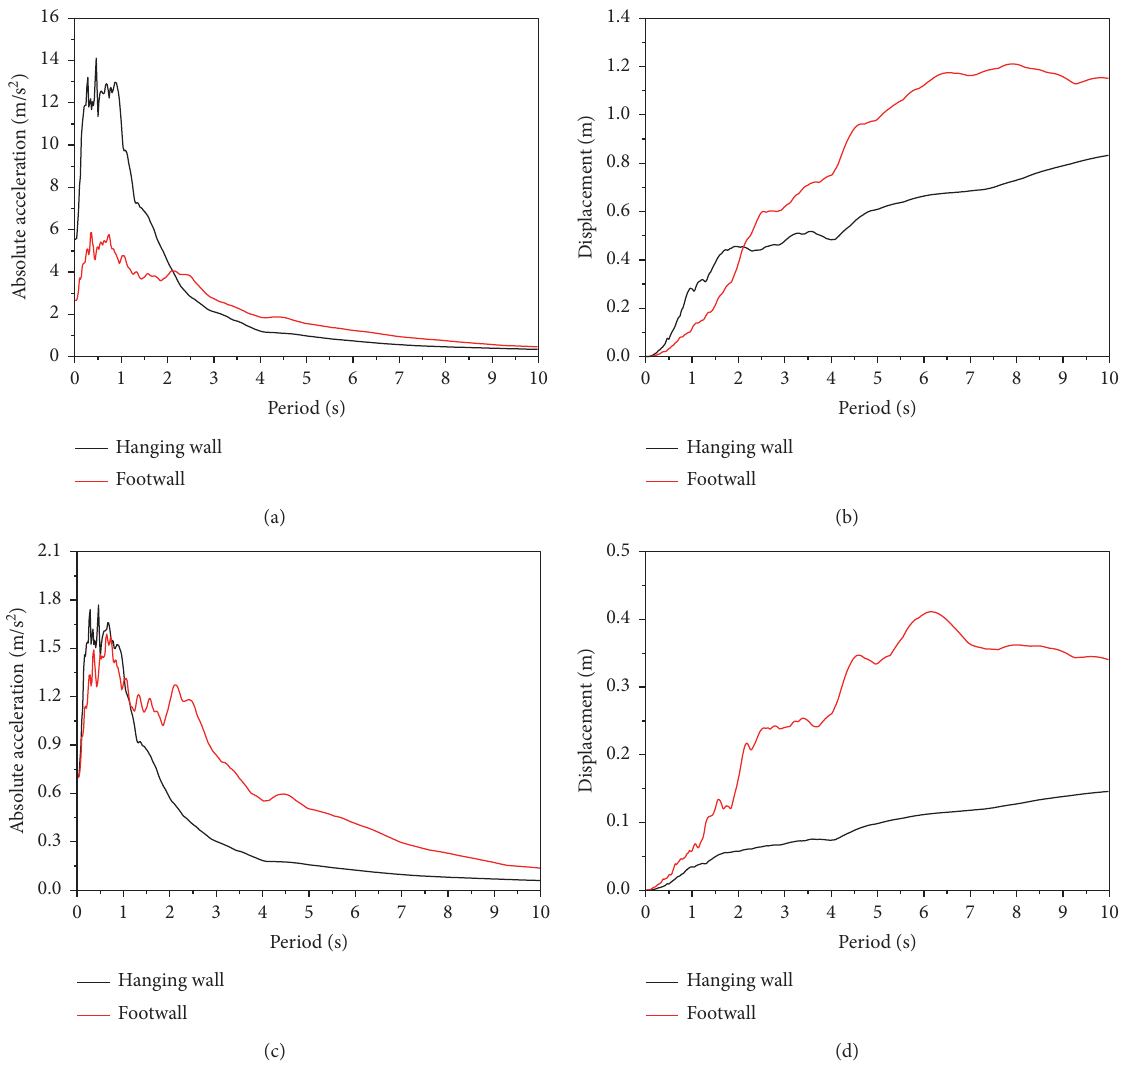
Figure 5: Response spectra of hanging wall and footwall waves: (a) acceleration spectra without amplitude modulation; (b) displacement spectra without amplitude modulation; (c) acceleration spectra with amplitude modulation; (d) displacement spectra with amplitude